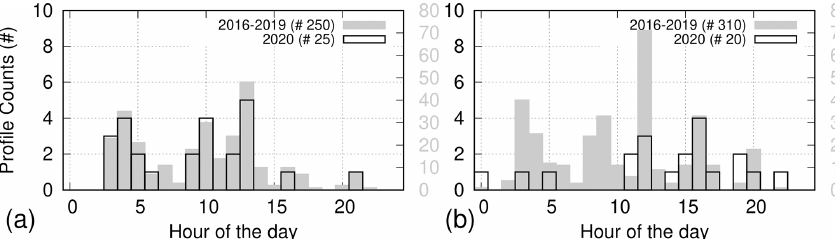
Figure 4. Number of profiles by hour of the day (UTC) for (a) March 2020 and (b) May 2020 (counts on left-hand axis) compared with the same months in the reference period of 2016–2019 (counts on right-hand axis).